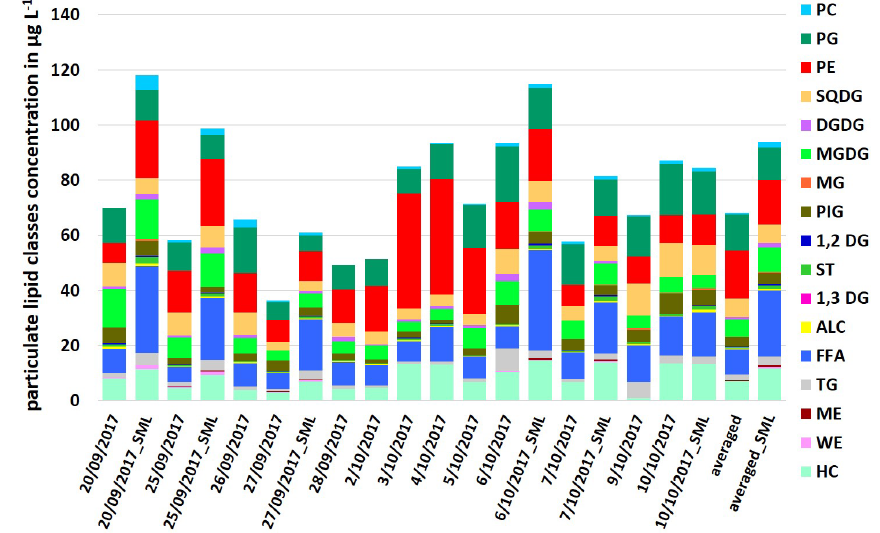
Figure 1. Concentration of individual particulate lipid classes in the ULW (sampling date) and the SML (sampling date_SML) samples along the campaign and as an averaged value in µgL − 1 .